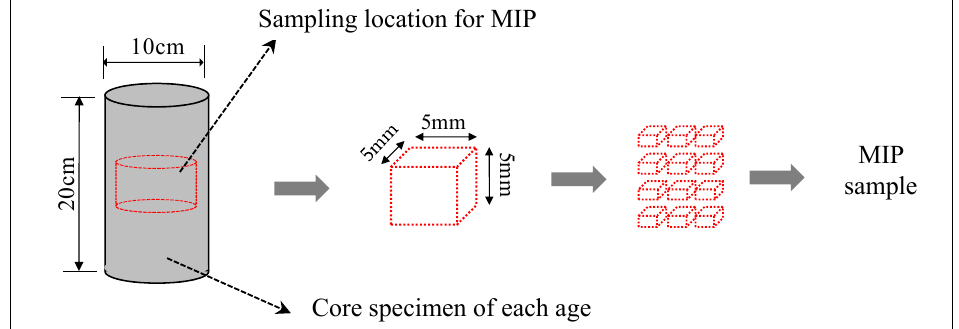
Figure 5. Experimental setup of mock-up test.